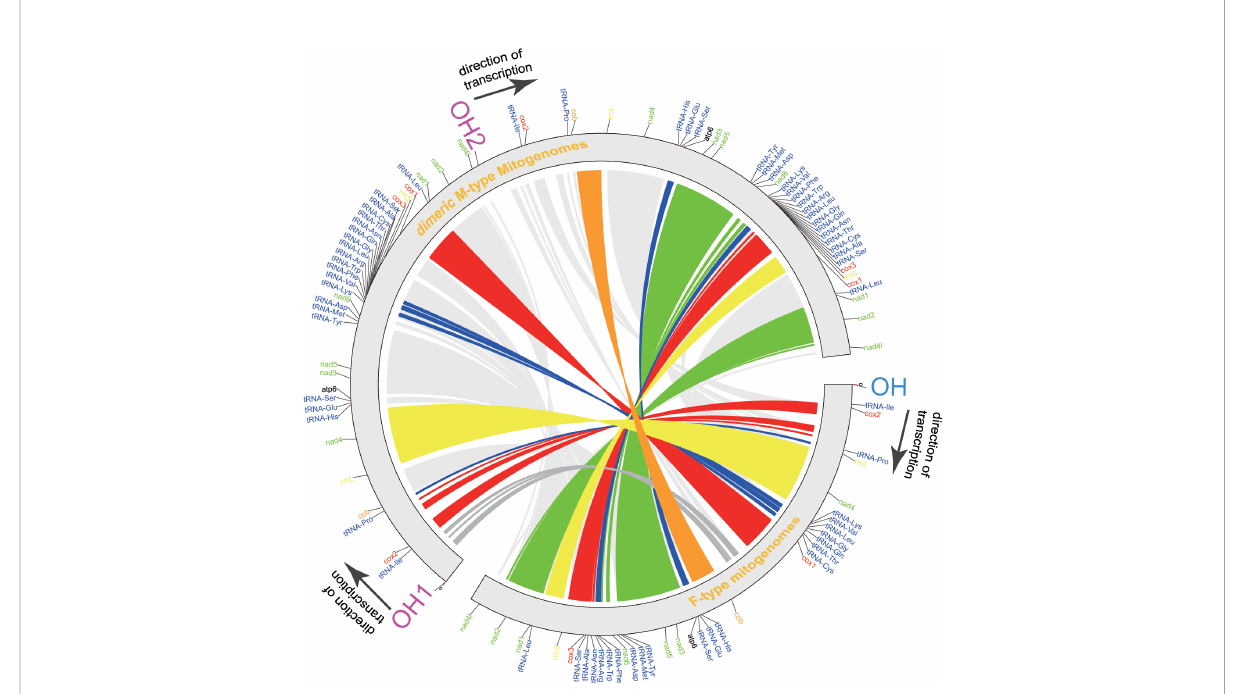
FIGURE 3 Circos diagrams synteny of dimeric M-type and F-type Macridiscus